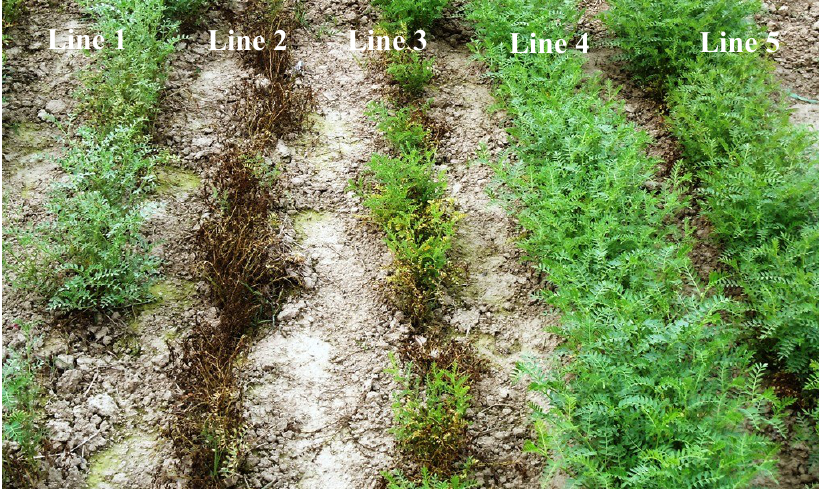
Figure 3. Variation for herbicide tolerance in chickpea. Left to right Line #1 (score